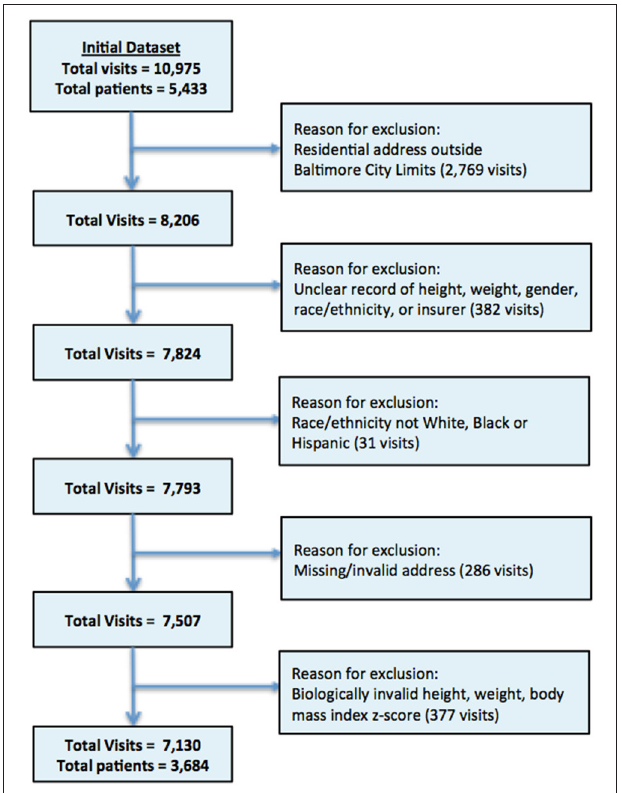
FIGURE 1 | Flow Chart patient data extraction process.